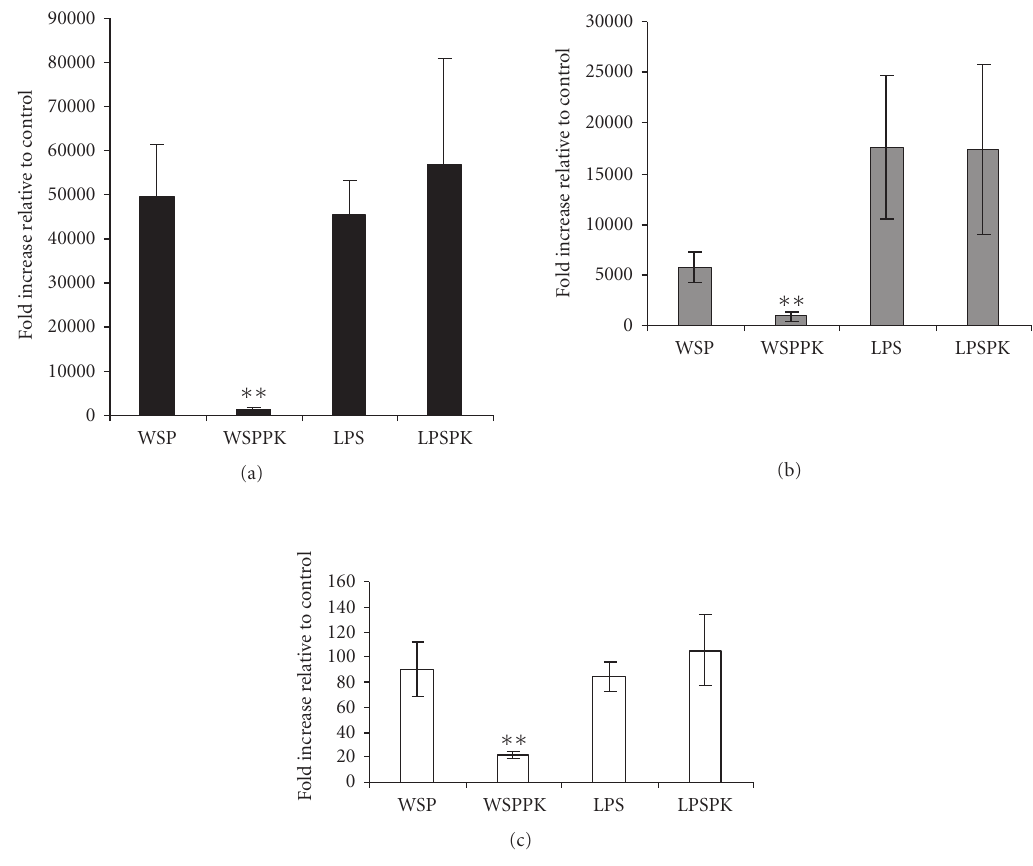
Figure 3: E ff ect of proteinase K treatment in rWSP-induced IL-1ˆa (a), IL-6 (b), and TNF (c) mRNAs expression in macrophage RAW 264.7 cells. The macrophage cells were incubated with 9 μ g/mL rWSP (WSP), 9 μ g/mL rWSP pretreated with proteinase K (WSPPK), 0.1 μ g/mL LPS (LPS), and 0.1 μ g/mL LPS pretreated with proteinase K (LPSPK) for 3 hours. The data represent mean values and standard deviations of fold increase of cytokine transcripts relative to negative control. Significant di ff erences were found between WSP- and WSPPK-treated cells ( P < . 05; indicated by ∗∗